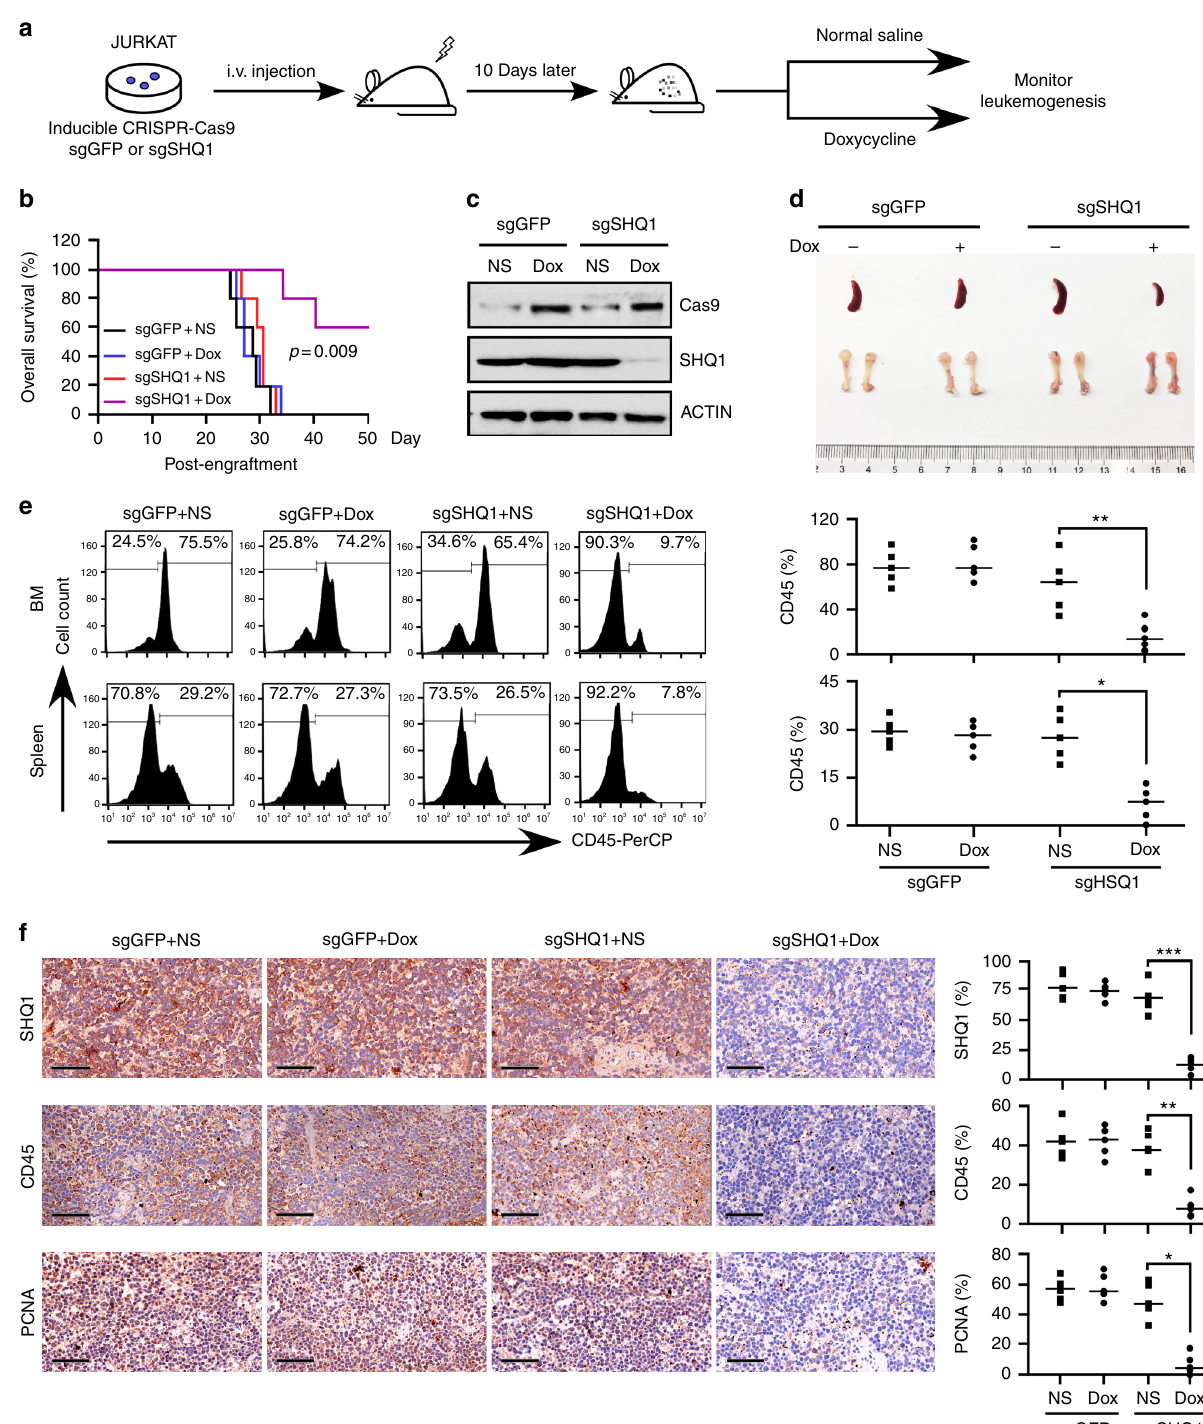
Fig. 4 SHQ1 knockout signi fi cantly decreases leukemia burden in the human T-ALL xenograft. a Schematic representation of human T-ALL xenograft. Two million JURKAT cells, expressing inducible CRISPR-Cas9 and sgRNA targeting GFP or SHQ1, were injected into irradiated NPG mice (1 gray). At 10 days post engraftment, doxycycline or normal saline was introduced into each allocated group for consecutive 7 days. b Kaplan – Meier survival curves of JURKAT xenografts in each group as indicated ( n = 5 for each group). Survival of doxycycline-treated or untreated sgSHQ1 mice (purple and red lines) are compared with p value provided as shown (log-rank test). Between 28 and 35 days post engraftment, treated (blue line) or untreated (black line) sgGFP mice became moribund and 5 mice were taken out in each group and killed for assessment of leukemia burden. c Cas9 and SHQ1 were analyzed in human CD45 + bone marrow cells obtained from representative mice in each group. d Representative spleen and bone images of mice carrying JURKAT cells with or without SHQ1 expression. e Human CD45 + cells from spleen and bone marrow (as shown in d ) were analyzed by fl ow cytometry. Data from fi ve individual mice were plotted and shown on the right. f Representative immunohistological images of SHQ1, human CD45, and PCNA in spleen sections from indicated mice. Scale bar, 50 μ m. Histological stain was quanti fi ed using ImageJ; * p < 0.05, ** p < 0.01, *** p < 0.001, unpaired t -test ( e , f